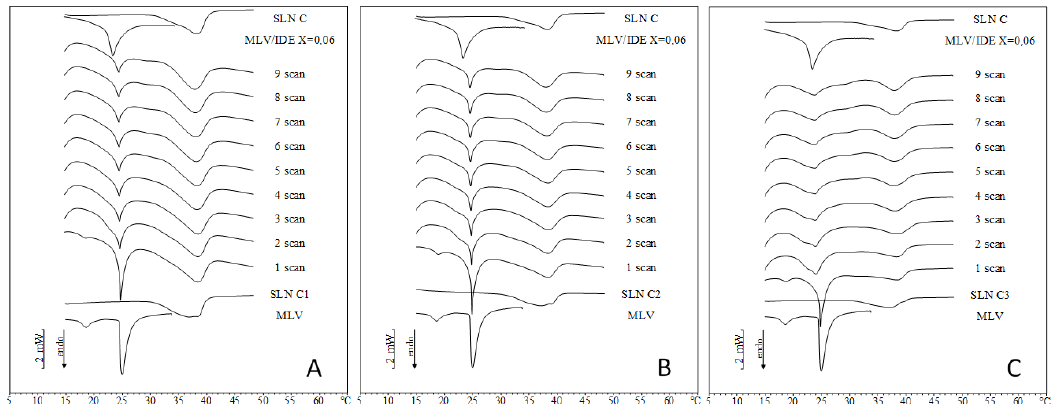
Figure 5. DSC scans during the interactions of IDE-loaded SLN with MLV liposomes. A = SLN C1; B = SLN C2; C = SLN C3.